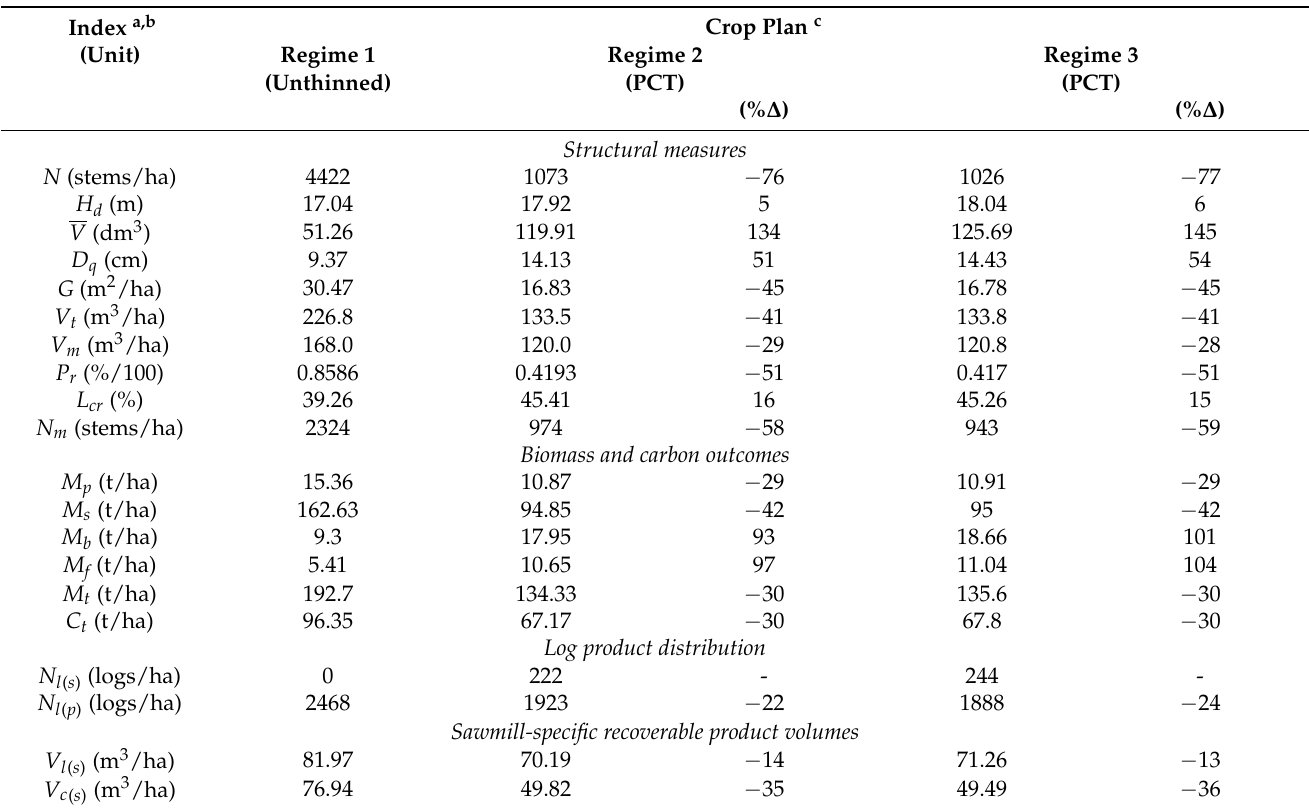
Table 4. Operability optimizer (automated crop plan selection): crop-plan-specific rotational (48, 48 and 52 yr for Regimes 1, 2 and 3, respectively) stand structure attributes, volumetric yields, log assortments, biomass and carbon outcomes, product volumes, end-product-related wood quality metrics, and productivity and economic indices, for natural-origin jack pine stands established at very high initial densities (8000 stems/ha) growing on medium-to-good quality sites (site index 18 m) which were left unthinned (Regime 1) or subjected to density control treatments (PCT of 6500 stems/ha at 15 yr deploying the maximum thinning response model setting (Regime 2); and PCT of 6500 stems/ha at 15 yr deploying the minimum thinning response model setting (Regime 3)).